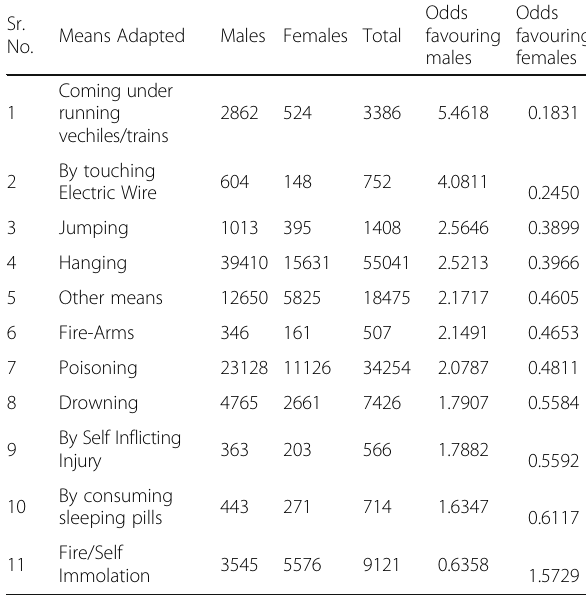
Table 5 Odds ratio for means adapted for suicides for males Sr.